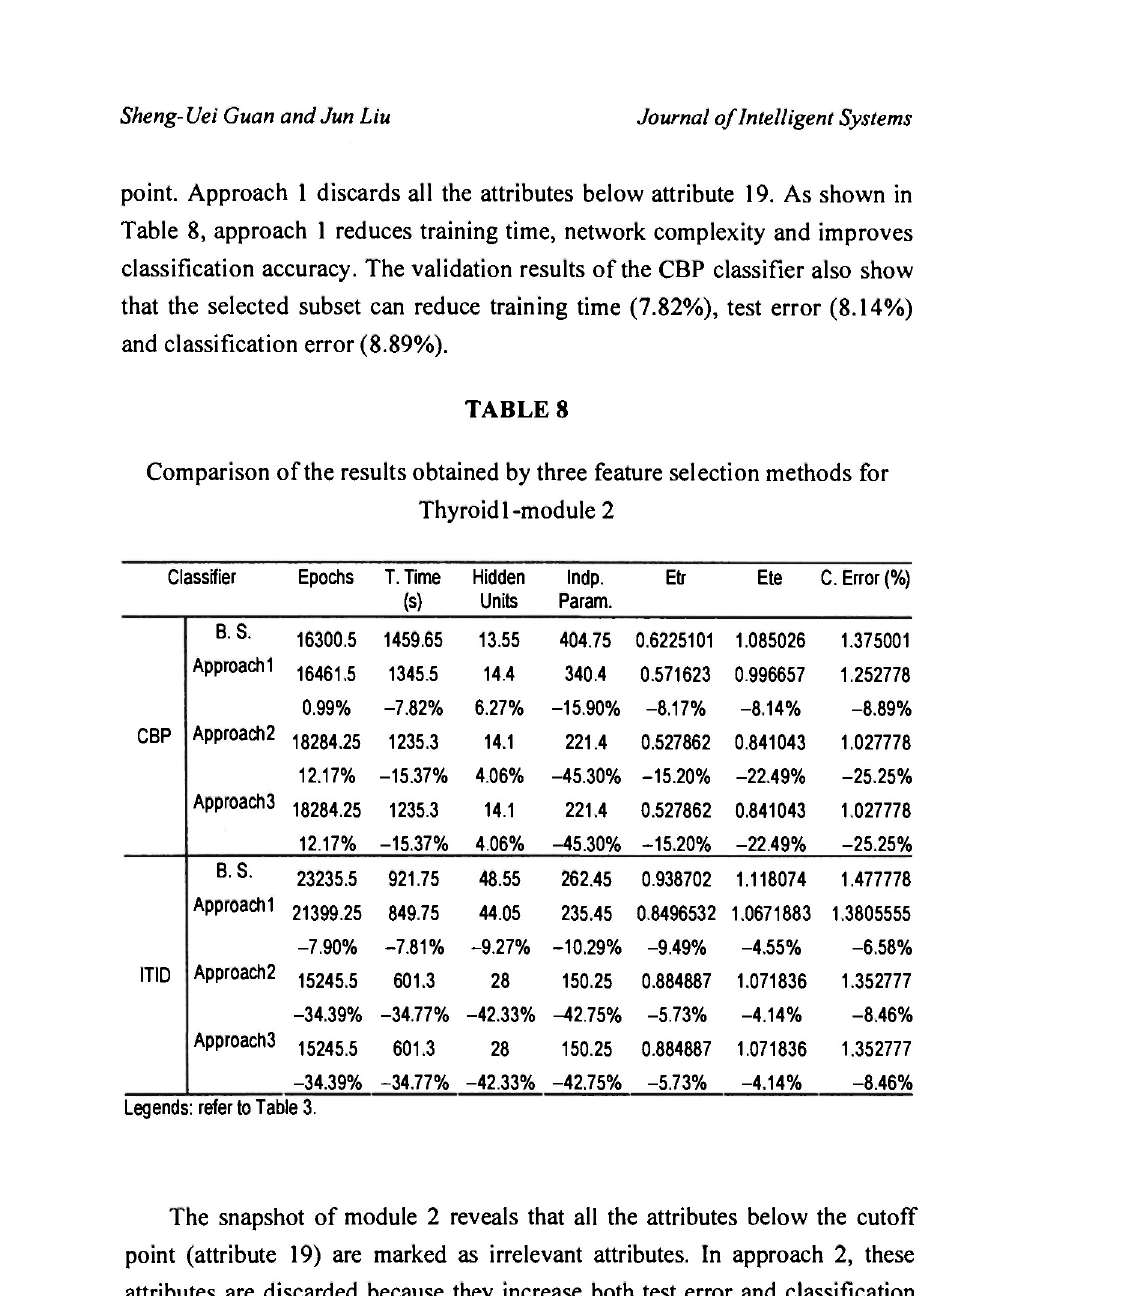
Legends: refer to Table